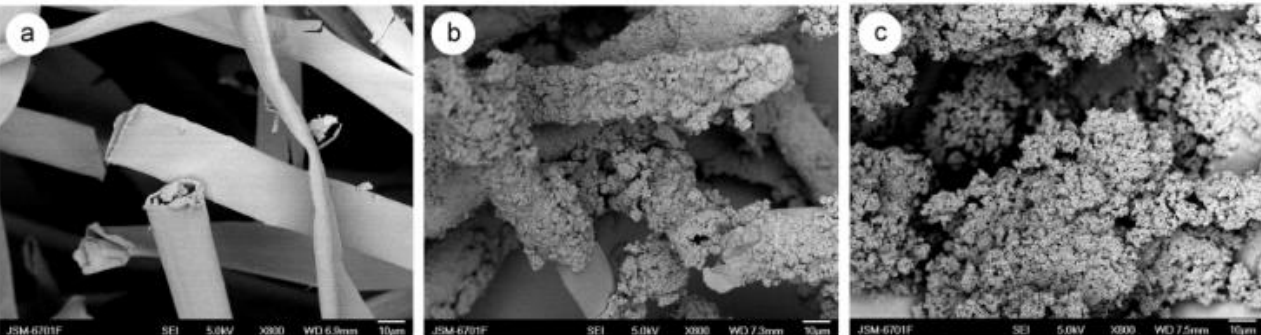
Figure 13. SEM images of ( a ) KF, ( b ) KF with polyaniline, and ( c ) polyaniline [71]. Reprinted (adapted) with permission from Zheng, Y., Liu, Y., & Wang, A., Kapok fiber oriented polyaniline for removal of sulfonated dyes. Industrial & engineering chemistry research, 51 (30), 10079 – 10087,